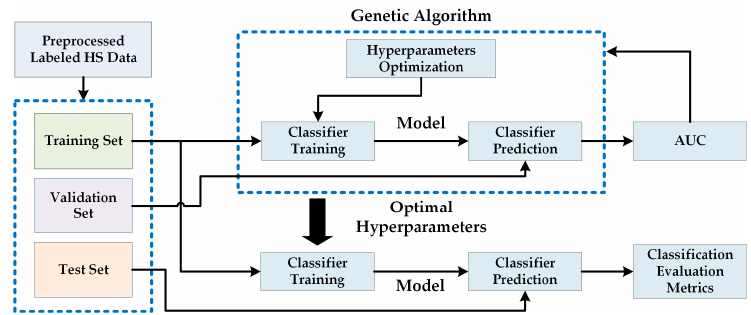
Figure 9. Proposed block diagram of the HS dermatologic classification processing framework.